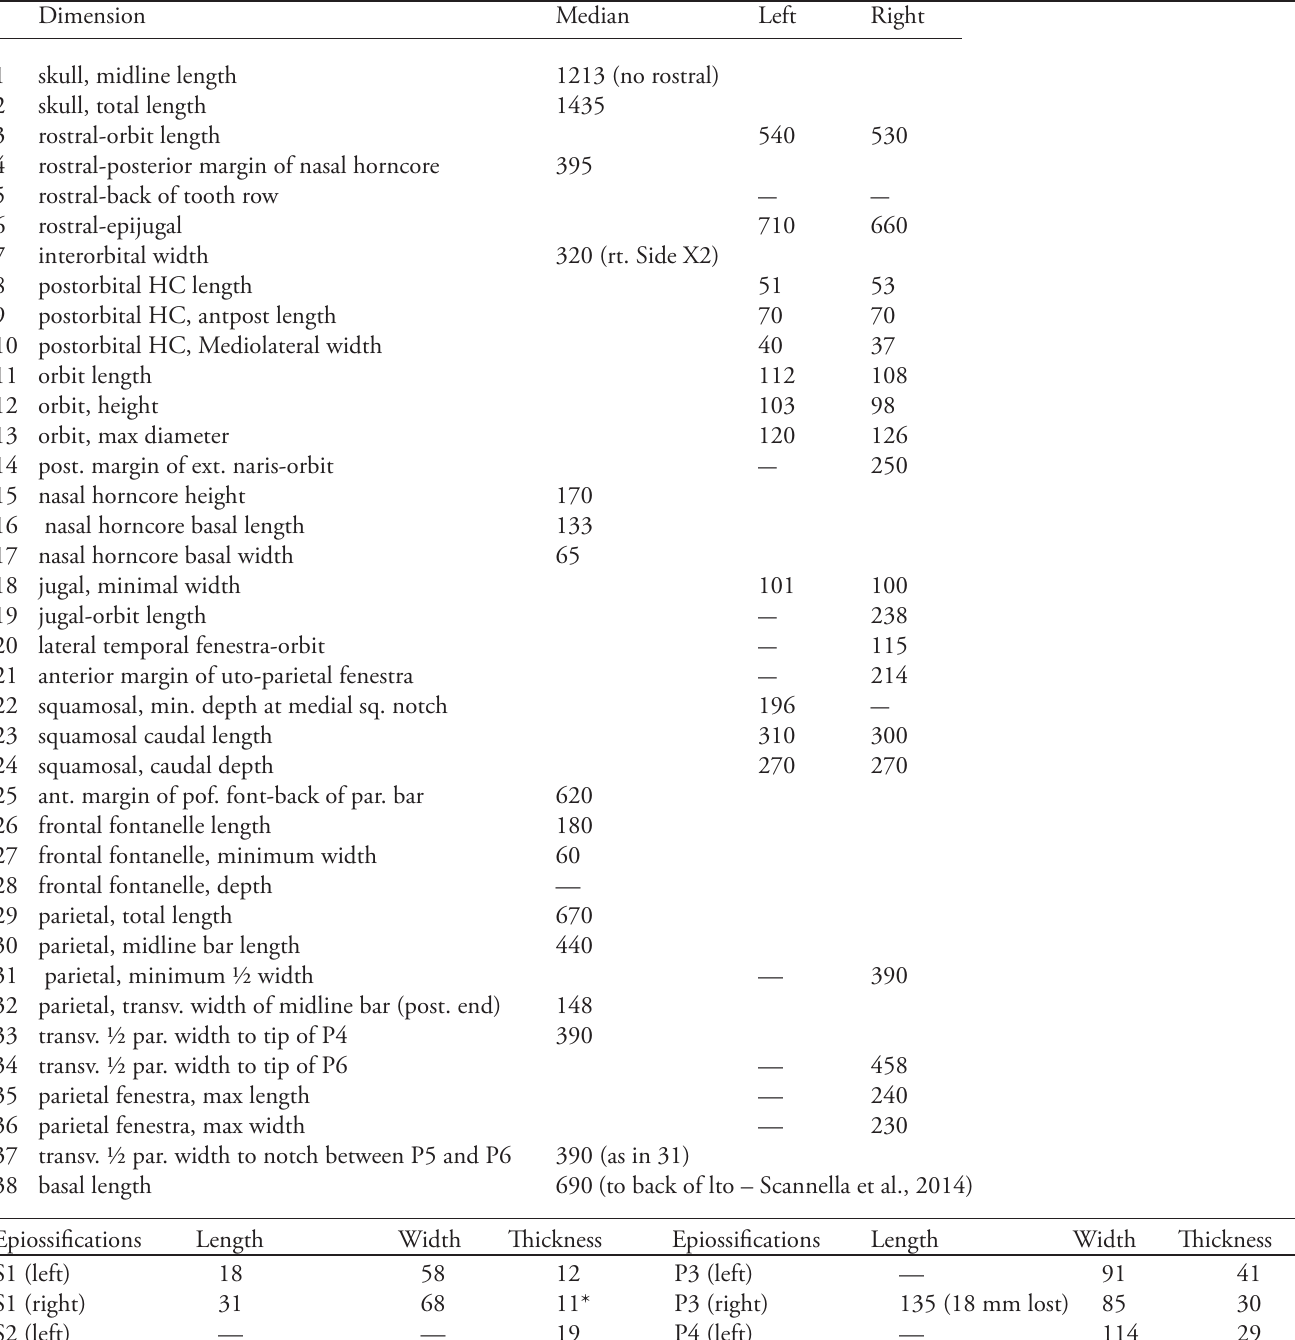
Table 1. Measurements of Styracosaurus skull TMP 2009.080.001 following numbering from Ryan et al. 2007. Measurements in mm.